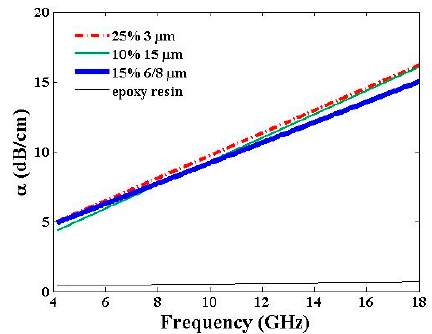
Figure 9. Electromagnetic absorption α vs. frequency of samples loaded with the maximum weight ratio of the related graphene particle sizes. Pristine epoxy resin values are given for reference.